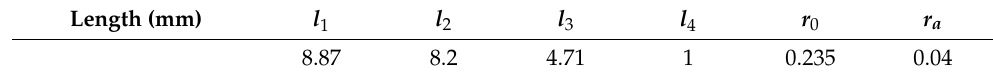
Table 1. Structure parameters of printhead.